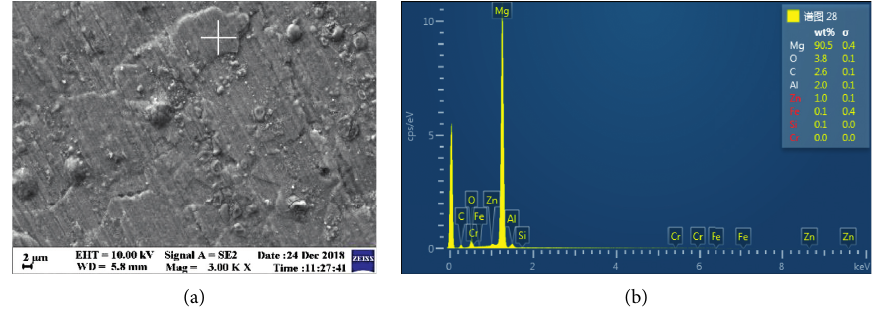
Figure 18: SEM (3000 times) micromorphology experiment and EDS analysis of the magnesium alloy plate after cathodic protection